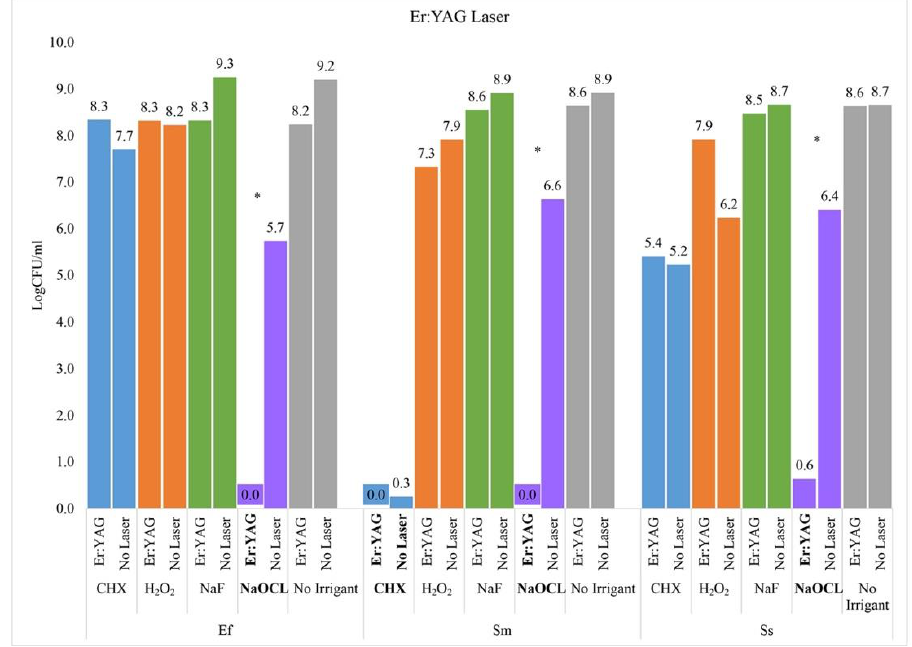
Figure 2. Er:YAG Laser. Asterisk indicates a statistically significant difference between the two groups (i.e. Laser+Irrigant vs Irrigant Alone) based on Tukey’s adjusted pairwise comparisons. (i.e., Laser + Irrigant vs. Irrigant Alone) based on Tukey’s adjusted pairwise